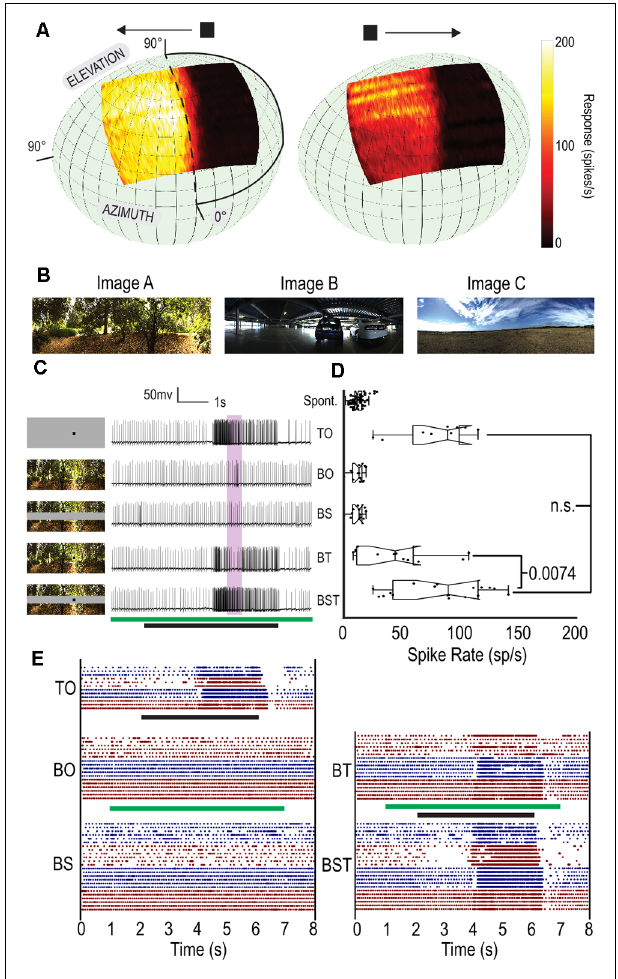
FIGURE 1 | A gray strip can maintain constant, local contrast for small, moving targets. (A) Averaged receptive field for CSTMD1 superimposed on animal’s visual field ( n = 11). CSTMD1 is a binocular large-field STMD with an excitatory and inhibitory hemifield, preferring targets moving away from the midline. (B) The three natural scenes used for experiments. (C) The five conditions with a corresponding example raw spike trace, Target Only (TO), Background Only (BO), Background with Strip (BS), Background with Target (BT) and Background with Strip and Target (BST). Stimulus timing shown by green (Background and Strip) and black (Target) bars. (D) Box plots of the five stimulus conditions. Each point represents spike rate in a 500 ms window (shown in purple in B ), in three neurons across three dragonflies (individual trials treated independently). (E) Raster plots for all stationary background trials separated by condition. Black stimulus bar indicates time target is moved on the display. Green stimulus bar indicates time background is moved on the display. Color changes (red, blue) represent different cells.